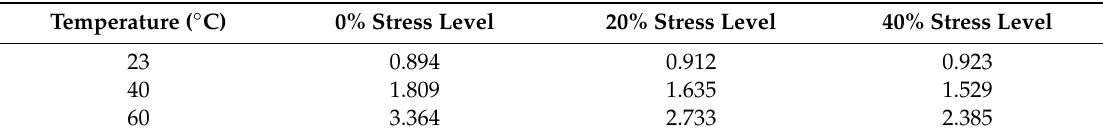
Table 8. Values for acceleration factors.